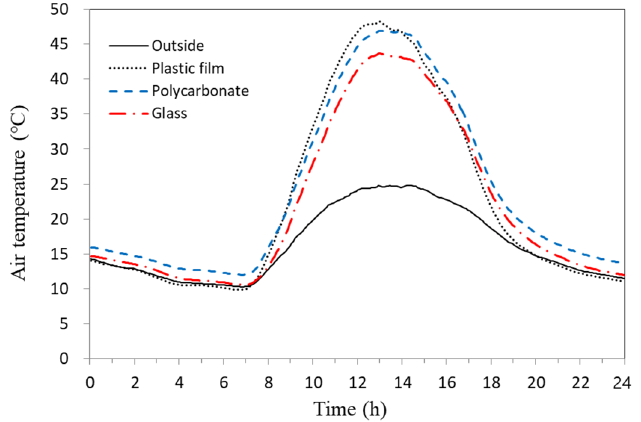
Figure 4. Variations in the outdoor and indoor air temperatures of greenhouses covered with dif- ferent covering materials (12 − 13, 19 − 20, and 26 − 27 October